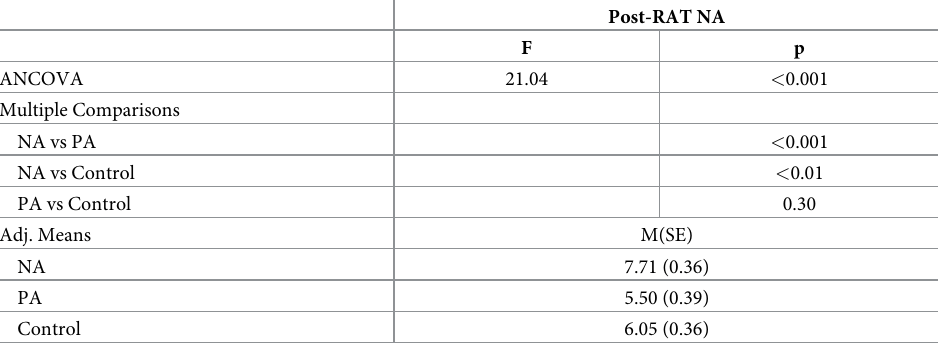
Table 4. ANCOVAs of post-RAT NA and PA controlling for pre-RAT NA with multiple comparisons across conditions.